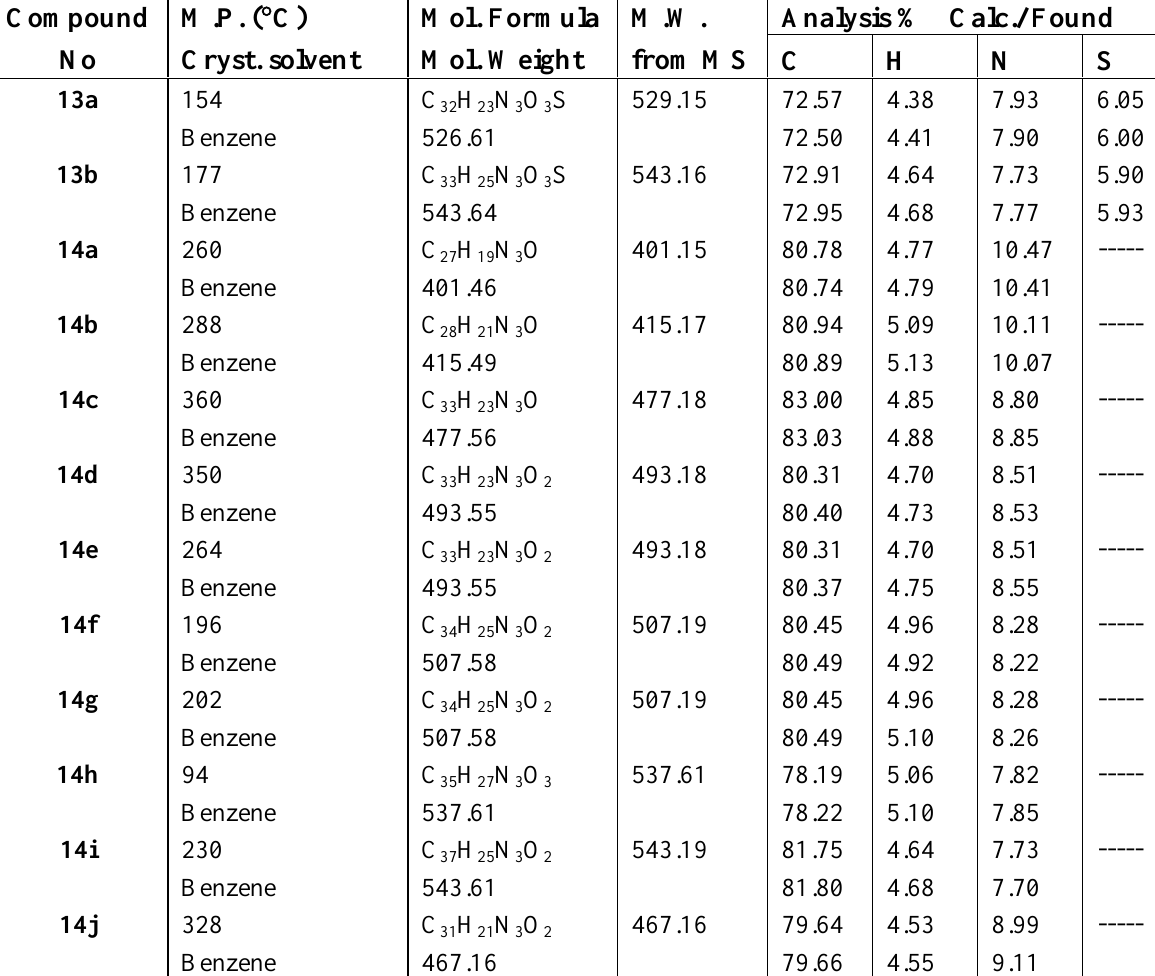
Analysis % Calc./ Found